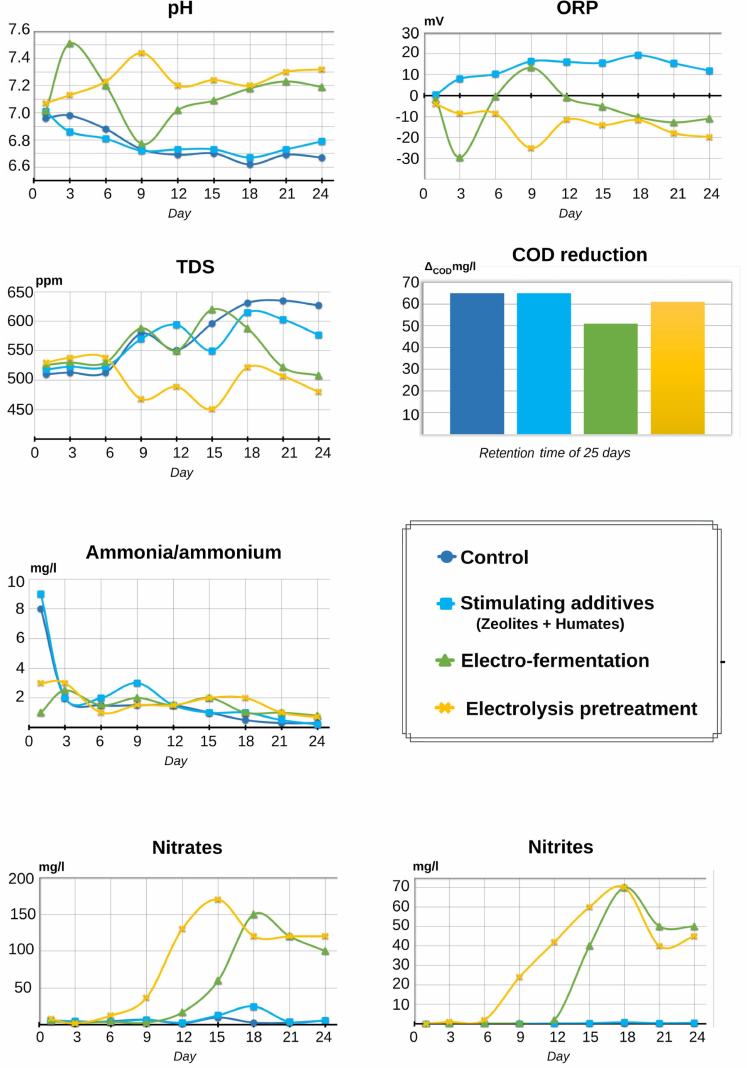
Figure 3. Dynamics of changes in the process of anaerobic digestion of clariid catfish droppings under different types of methanogenesis